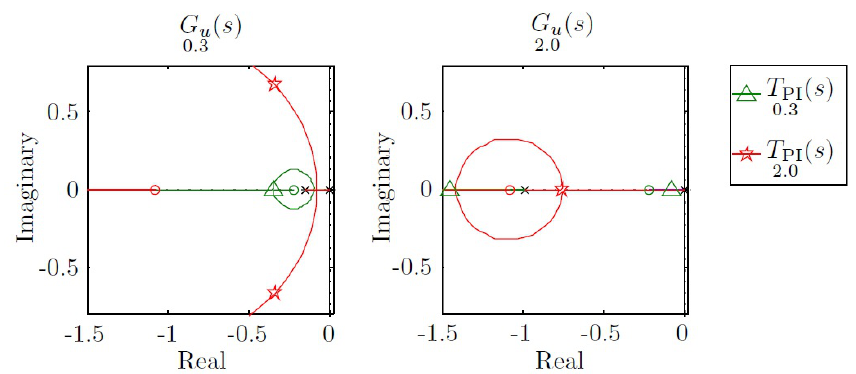
Figure 11. Root locus for G u 0.3 ( s ) and G u 2.0 ( s ) and pole displacement using controllers T PI 0.3 ( s ) and T PI 2.0 ( s )